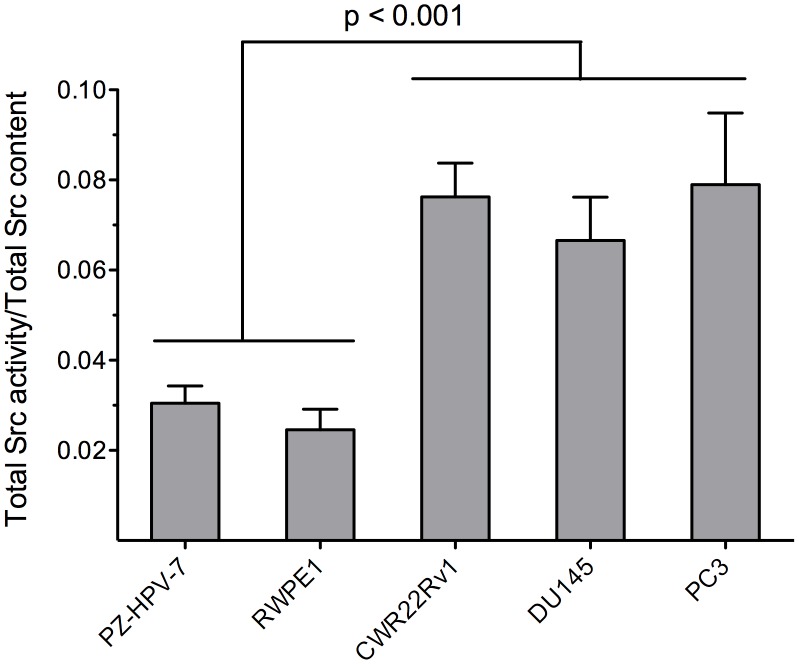
Src specific activity in non-invasive (PZ-HVP-7, RWPE1), androgen-independent (CWR22Rv1), and invasive (DU145, PC3) cell lines.Src kinase specific activity was calculated by dividing Src activity (Fig. 2) by total Src protein content (Fig. 3). Src specific activity is significantly higher in aggressive than in non-cancer cell lines (P<0.0001). Error bars are SEM.